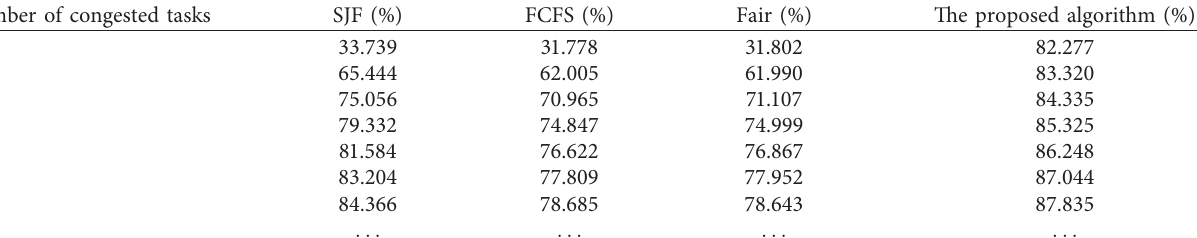
Table 6: Task congestion degree.